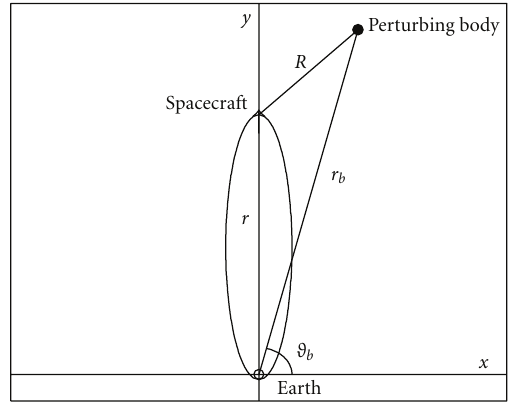
Figure 1: Schematic geometry of gravitational